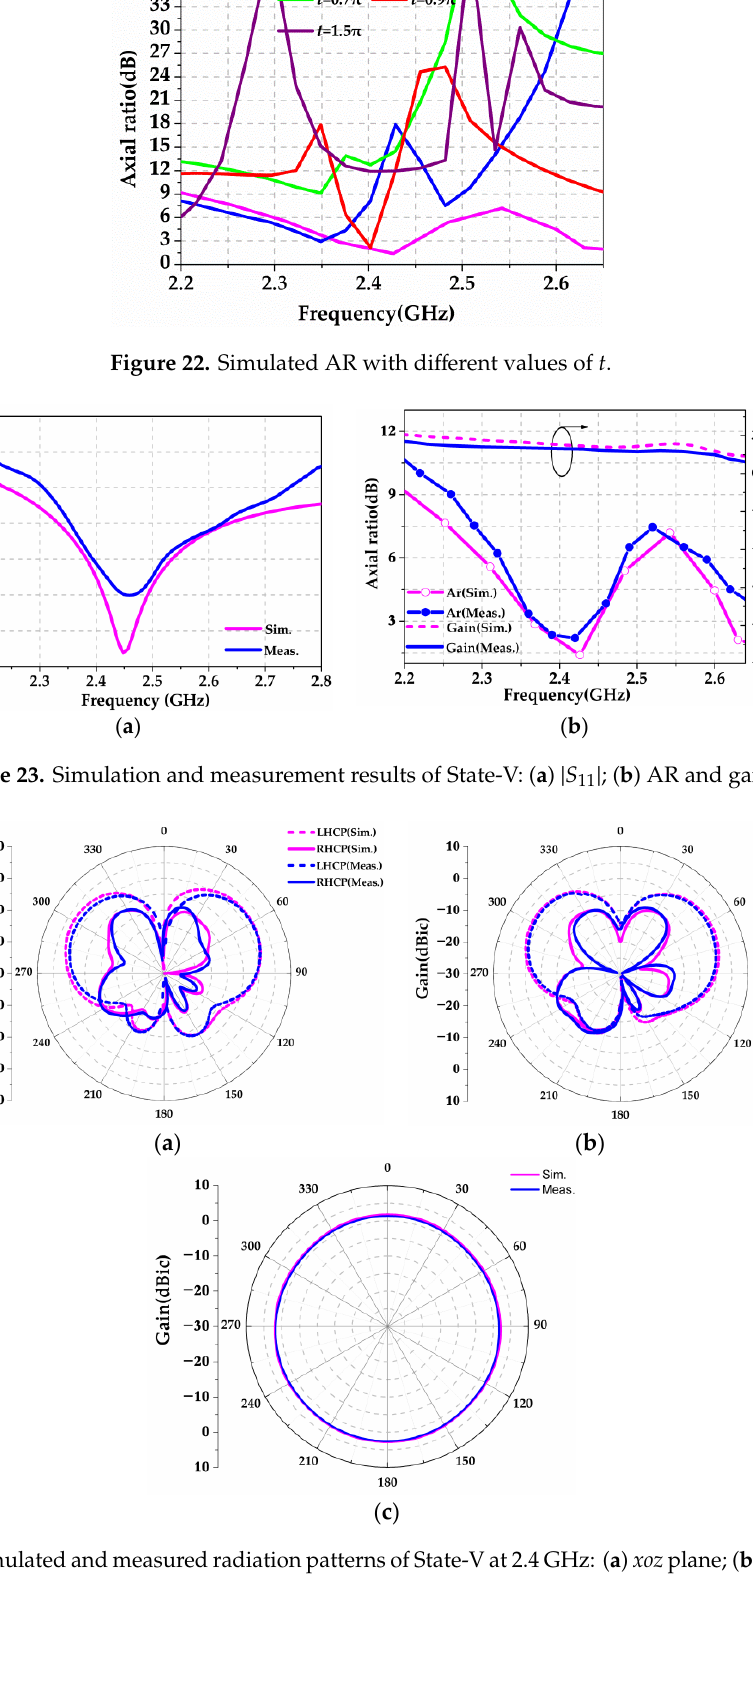
Figure 24. Simulated and measured radiation patterns of State-V at 2.4 GHz: ( a ) xoz plane; ( b ) yoz plane; ( c ) xoy plane .